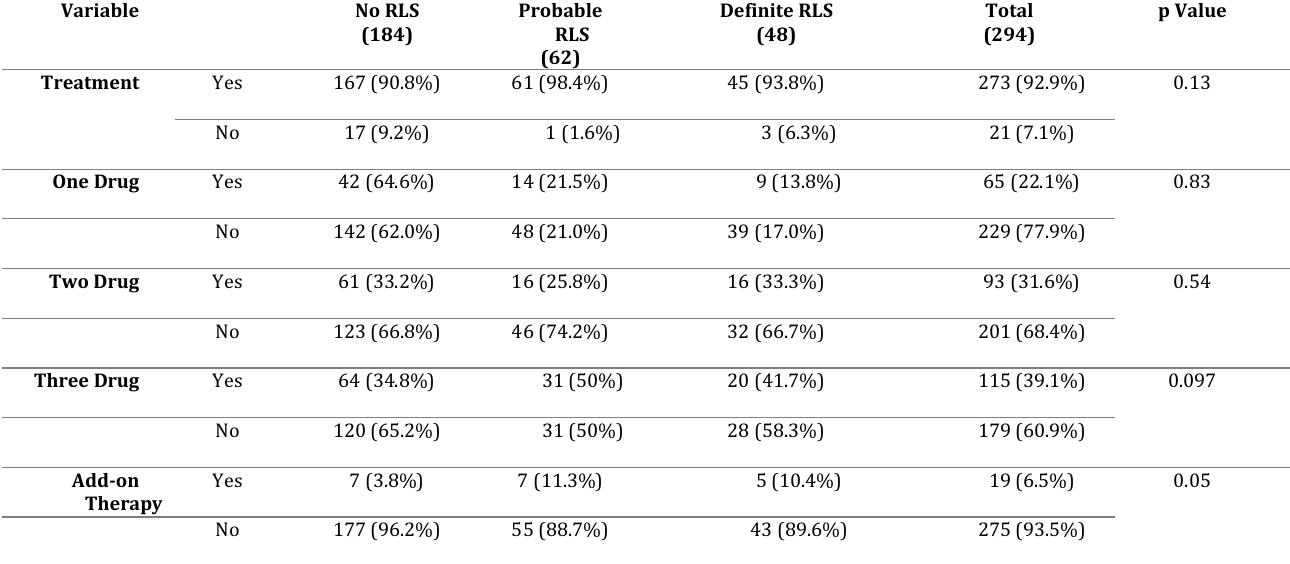
Table 5: Treatment profile of COPD and its association with RLS